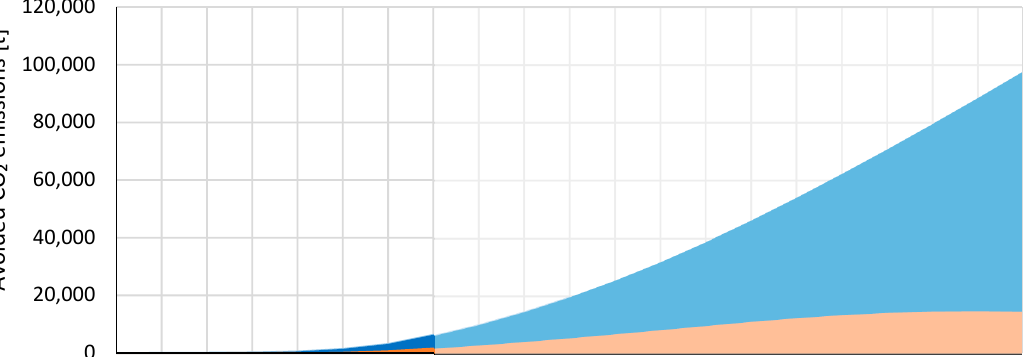
Figure 8. Summary of the cumulative reduction of CO 2 emissions resulting from the replacement of internal combustion with electrical vehicles, including values corrected in 2010–2017 with a forecast by 2030.